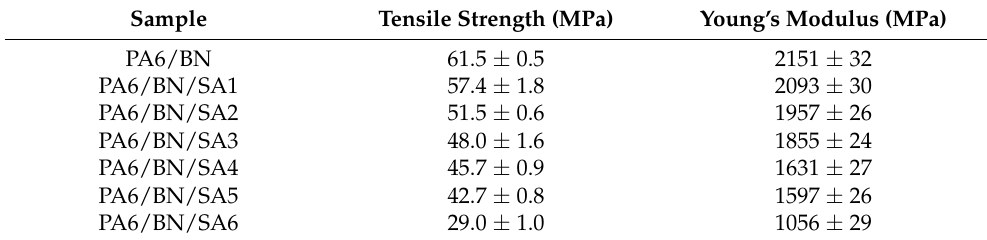
Table 3. Mechanical property of